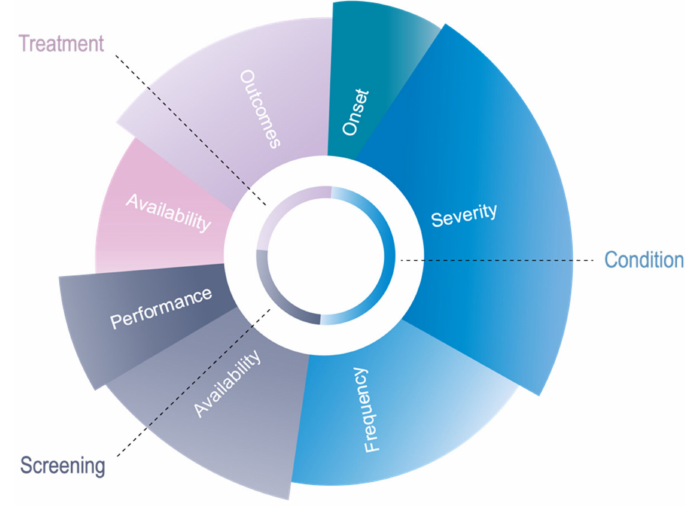
Figure 2. Components of novel algorithm.